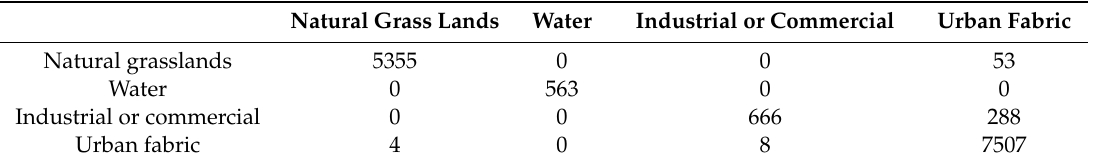
Table 10. Example of a detail of the confusion matrix for ground truth in the DaNang city area, Vietnam (Figure 13) in